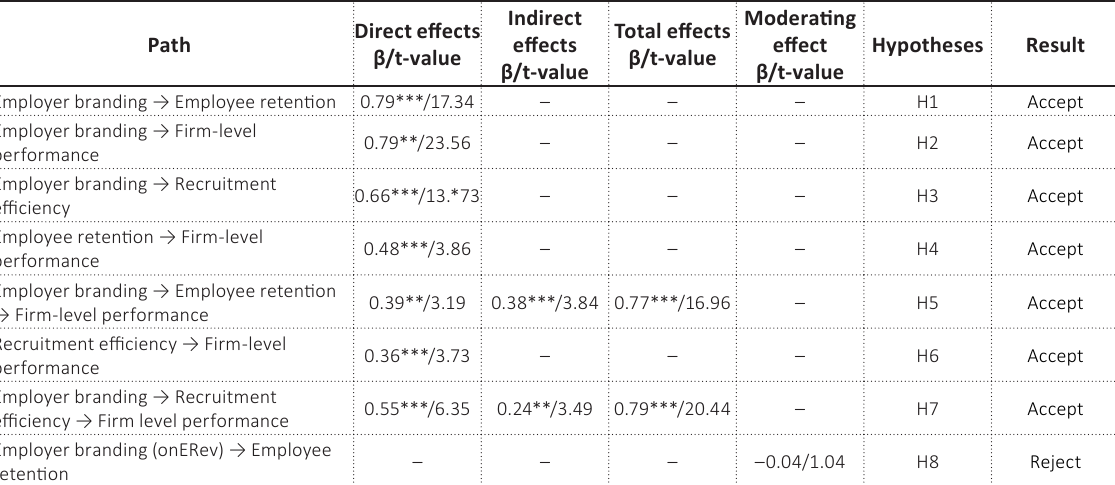
Table 4. Hypotheses